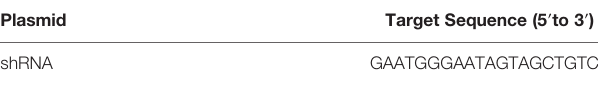
TABLE 4 | Target sequences of interfering plasmids of rat Foxc1. Plasmid